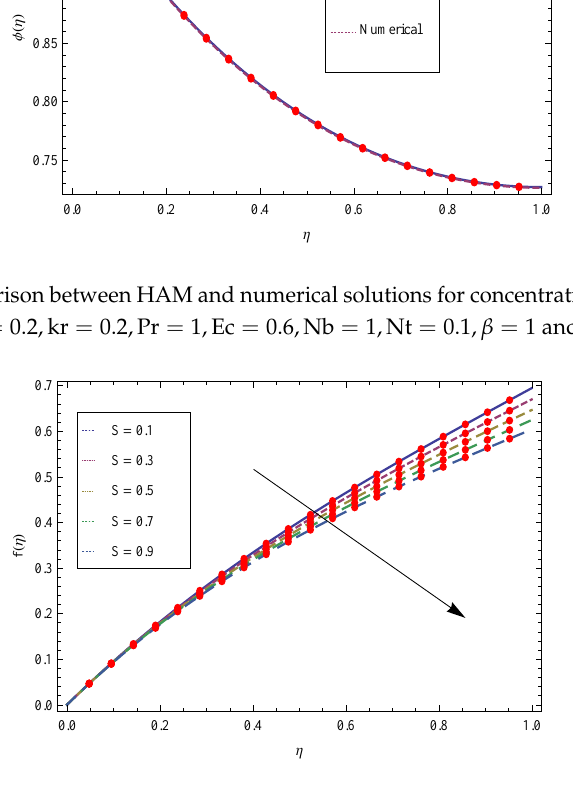
Figure 5. Variations in the Velocity field f ( η ) for various values of S , when h = − 0.25, λ = 0.9,kr = 0.9, Pr = 0.5,Ec = 0.5,Nb = 0.5,Nt = 0.6, β = 1, Sc =